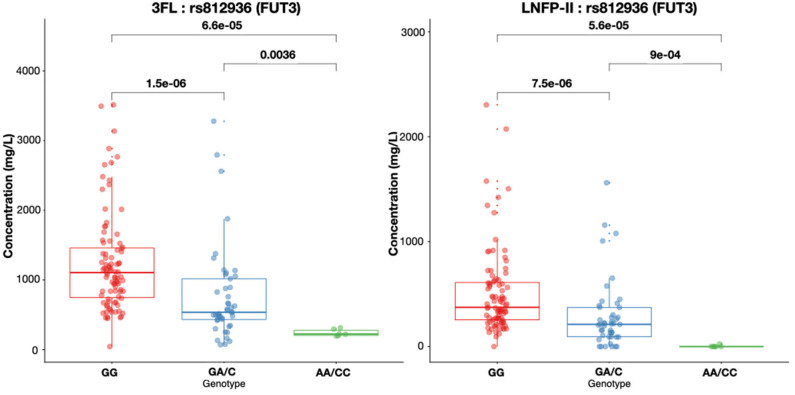
3FL and LNFP-II concentrations in mg/L in breast milk according to rs812936 genotypes. Box plots with median and 25 and 75% interquartiles and 95% CI are shown.